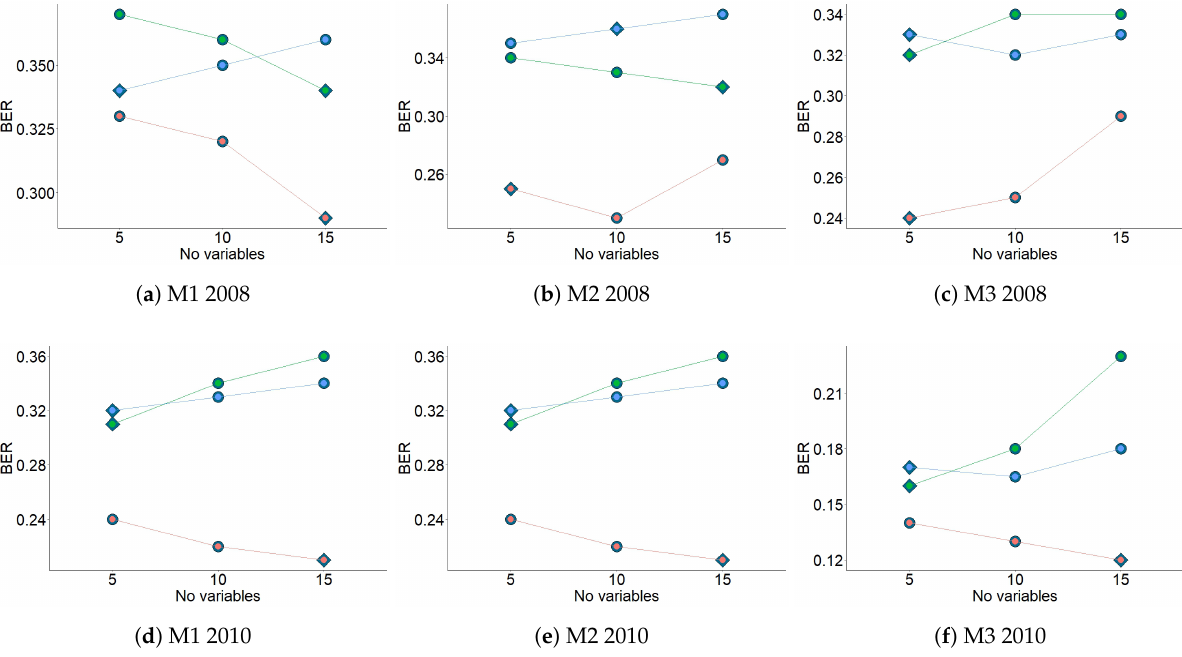
Figure 8. BER according to the number of variables (5, 10 or 15) and different number of components (1: orange dots, 2: blue dots, or 3: green dots) for each method, for 2008 and 2010. Three-fold CV was run 1000 times using centroid distance prediction. Diamonds indicate the optimal number of variables per component according to the lowest value of